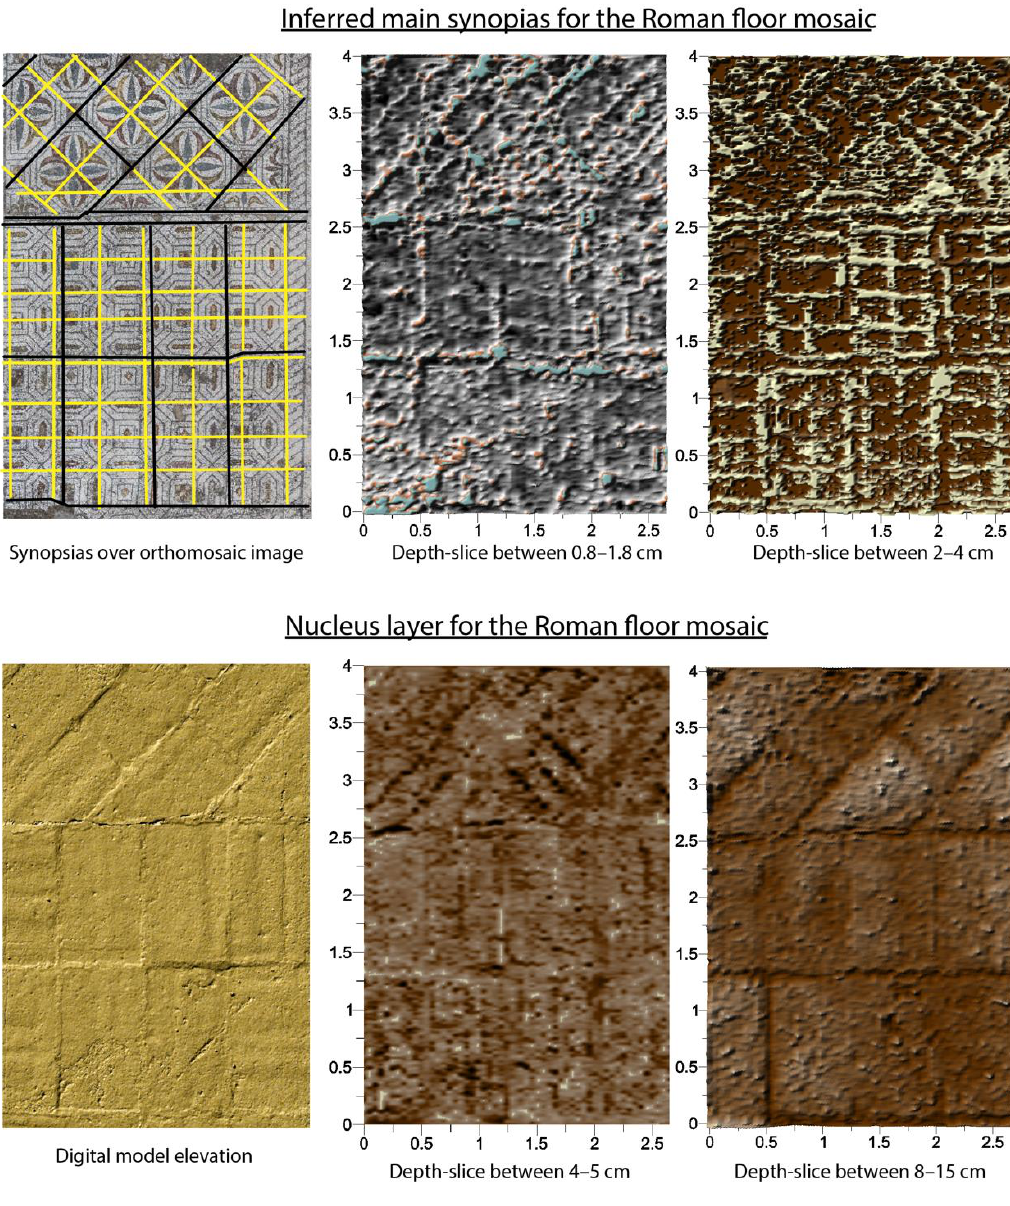
Figure 12. Upper images are the orthophoto (left) and two horizontal depth slices in the 3D-GPR model. Through the reflectors, we can infer the main sinopia of the Roman floor mosaic that is placed over the orthomosaic image (see discussion). Lower images are the digital surface model (DSM, left) and two horizontal depth slices cutting the nucleus: The first one is near the top of the nucleus, and the second integrates 7 cm of the nucleus body. Finally, the reflectivity correlates very well with the DSM